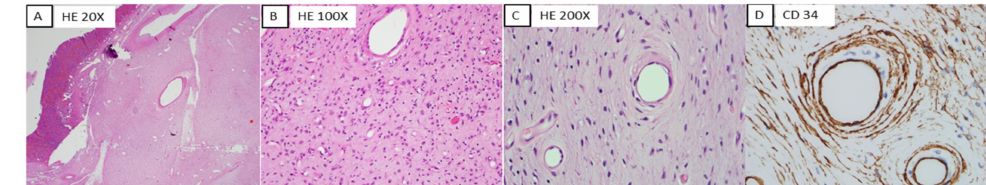
Figure 4. Histology findings of the tumor. ( A ) The inflammatory fibroid polyp (IFP) is a well- marginated but unencapsulated lesion arising from the submucosa of the ileum. (HE, 20 × ); ( B ) The IFP forms a fibrotic background with ovoid-to-spindle-shaped spindle cells mixed with eosinophils, lymphocytes, and plasma cells. (HE, 100 × ); ( C ) High magnification of the lesion shows that the cells form a whorled pattern, also called “onion skin,” which proliferated around the vessels. (HE, 200 × ); ( D ) The immunohistochemistry of CD34 is positive for the spindle cells and highlights whorled patterns around the vessels. (Immunohistochemical stain, 200 ×